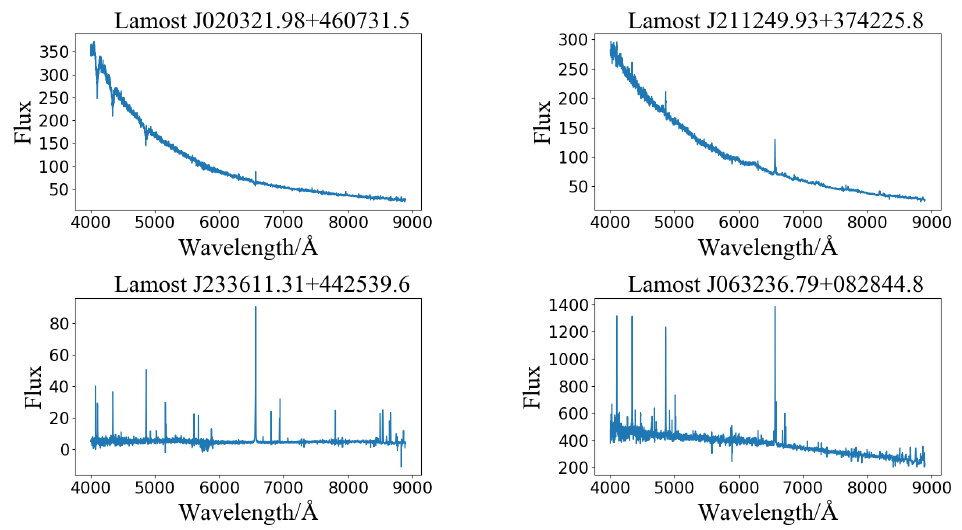
Figure 7. Spectra of new CV